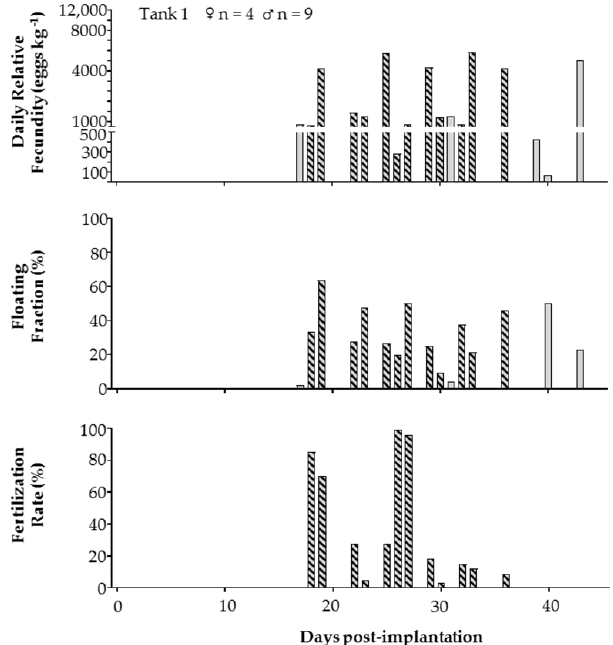
Figure 4. Trial 2B, high dose tank only: Spawning performance of first filial (F1) h¯apuku ( Polyprion oxygeneios ) maintained on an annually cycling regime from cool temperatures in the winter months (10.0–12.5 ◦ C) to warmer temperatures (17 ◦ C) in the summer months prior to being held at 13.5 ◦ C for the spawning season. Females were administered 1 mg GnRHa implants (high dose) ( n = 5; target dose of 100 µ g / kg − 1 ; achieved dose 95–145 µ g / kg − 1 ) and males were administered implants containing a dose of 0.5 mg GnRHa ( n = 9; target dose of 50 µ g / kg − 1 ; achieved dose 38–53 µ g / kg − 1 ). Data are shown as estimates of daily relative fecundity (number of eggs produced per kg − 1 of mean body weight of the females in each tank), the percentage of floating eggs and the percentage of fertilized eggs from each spawning event. Striped and blank bars represent batches of eggs where fertilization was detected or absent, respectively. No eggs were detected from the tank containing low-dose treated